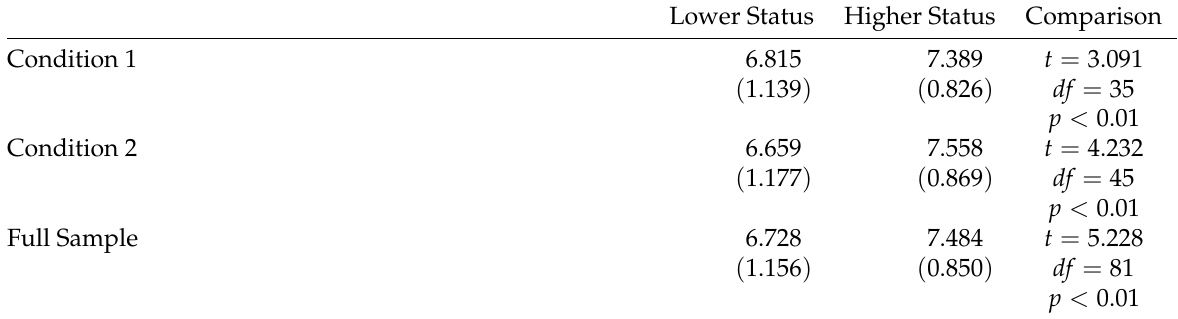
Table 4: Manipulation check: paired-samples t tests comparing self-reported general performance